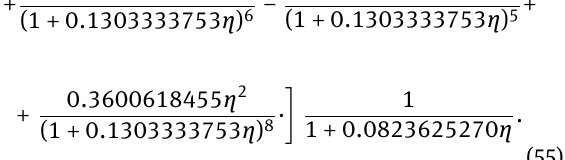
Table 7: Comparison between the limit value ¯ f (∞) obtained by means of the OHAM and numerical results, for λ = 0.1 and dif- ferent values of the suction/blowing parameter S (relative errors: